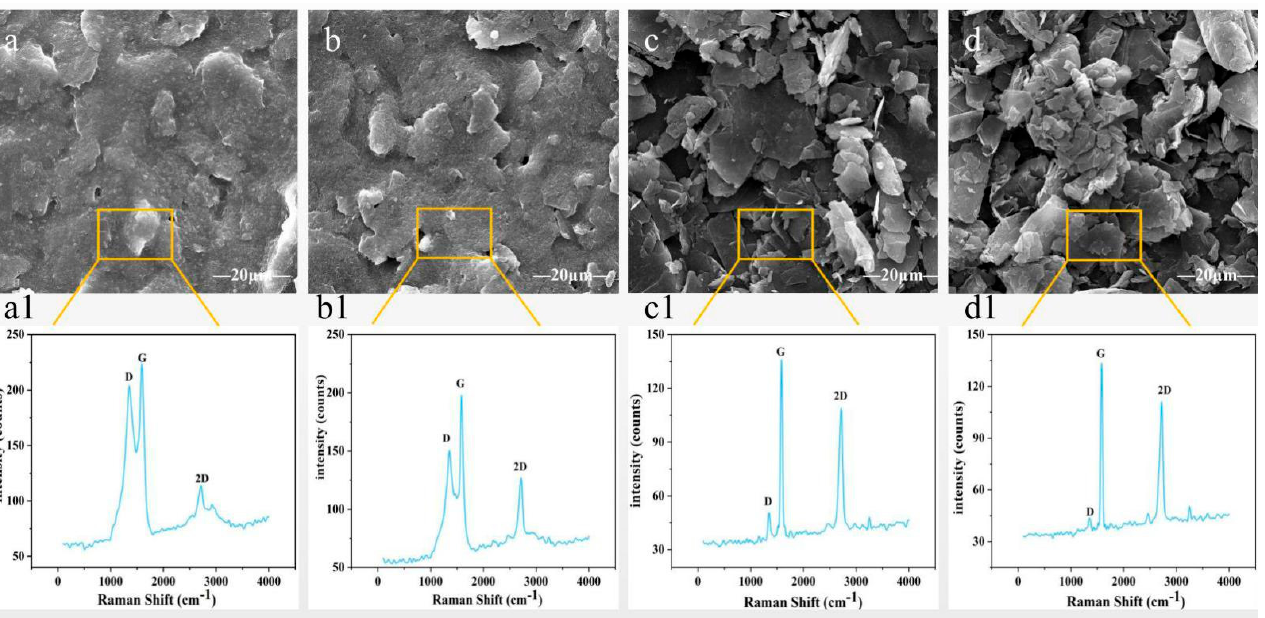
Figure 4. ( a – d ) SEM images of CCP/LIG with different LIG contents and ( a1 – d1 ) corresponding Raman spectra: ( a ) CCP + 0%LIG; ( b ) CCP + 3%LIG; ( c ) CCP + 5%LIG; and ( d ) CCP + 7%LIG.